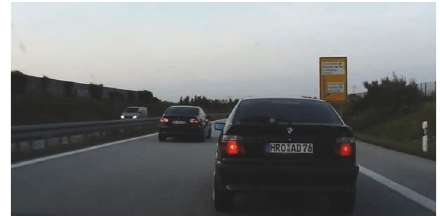
Figure 2: Picture following description of scenario 2.